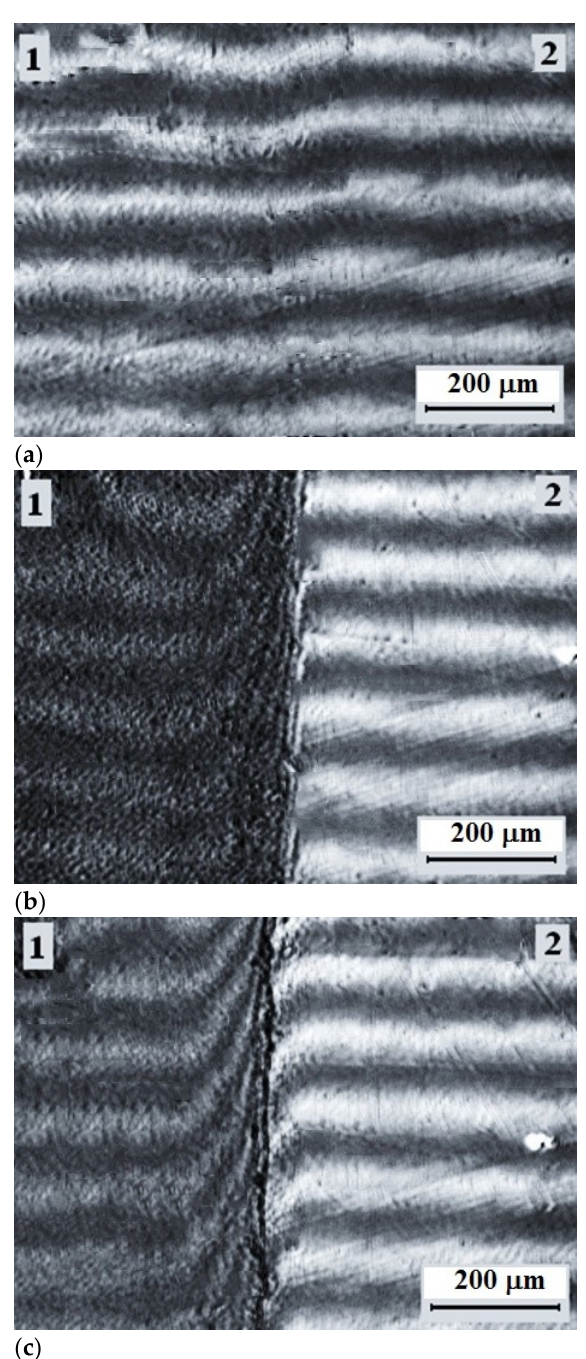
Figure 10. Interferograms of the interdiffusion zone of the HDPE-1 (1)-LLDPE (2) system obtained by isothermal aging at 122 °C after crossing the liquidus line. Annealing times: ( a ) 10; ( b ) 40; ( c ) 100 s.